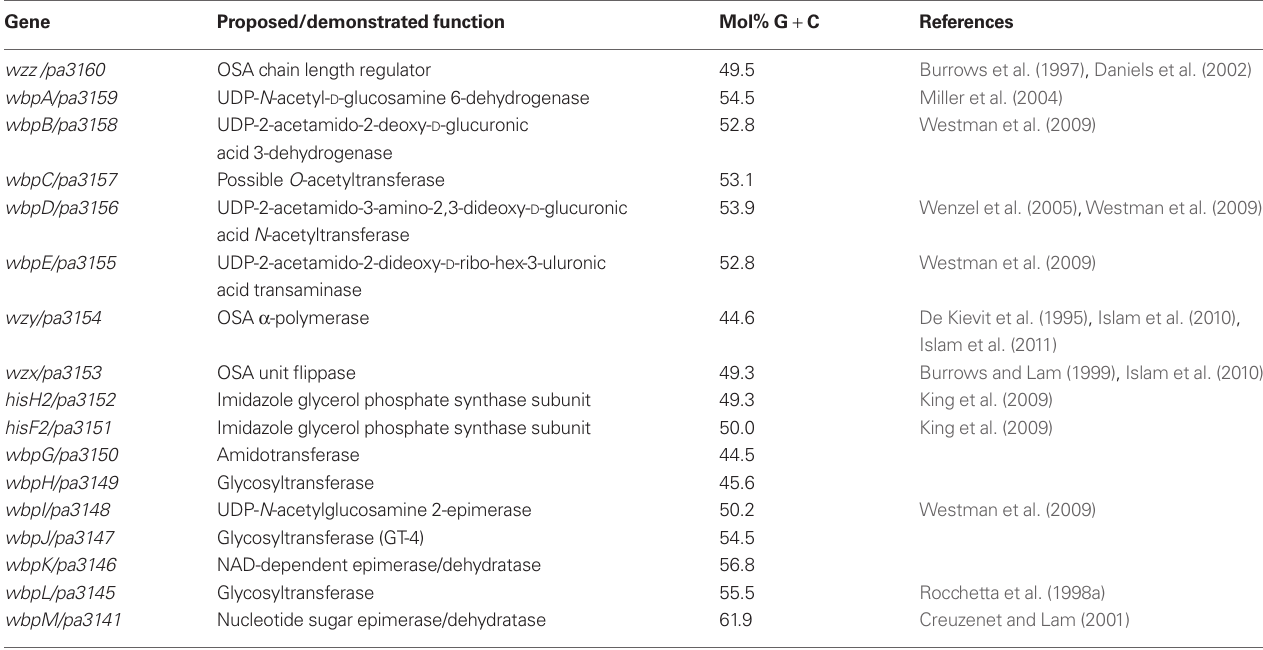
Table 2 | P. aeruginosa PAO1 serotype O5 OSA biosynthesis cluster*.